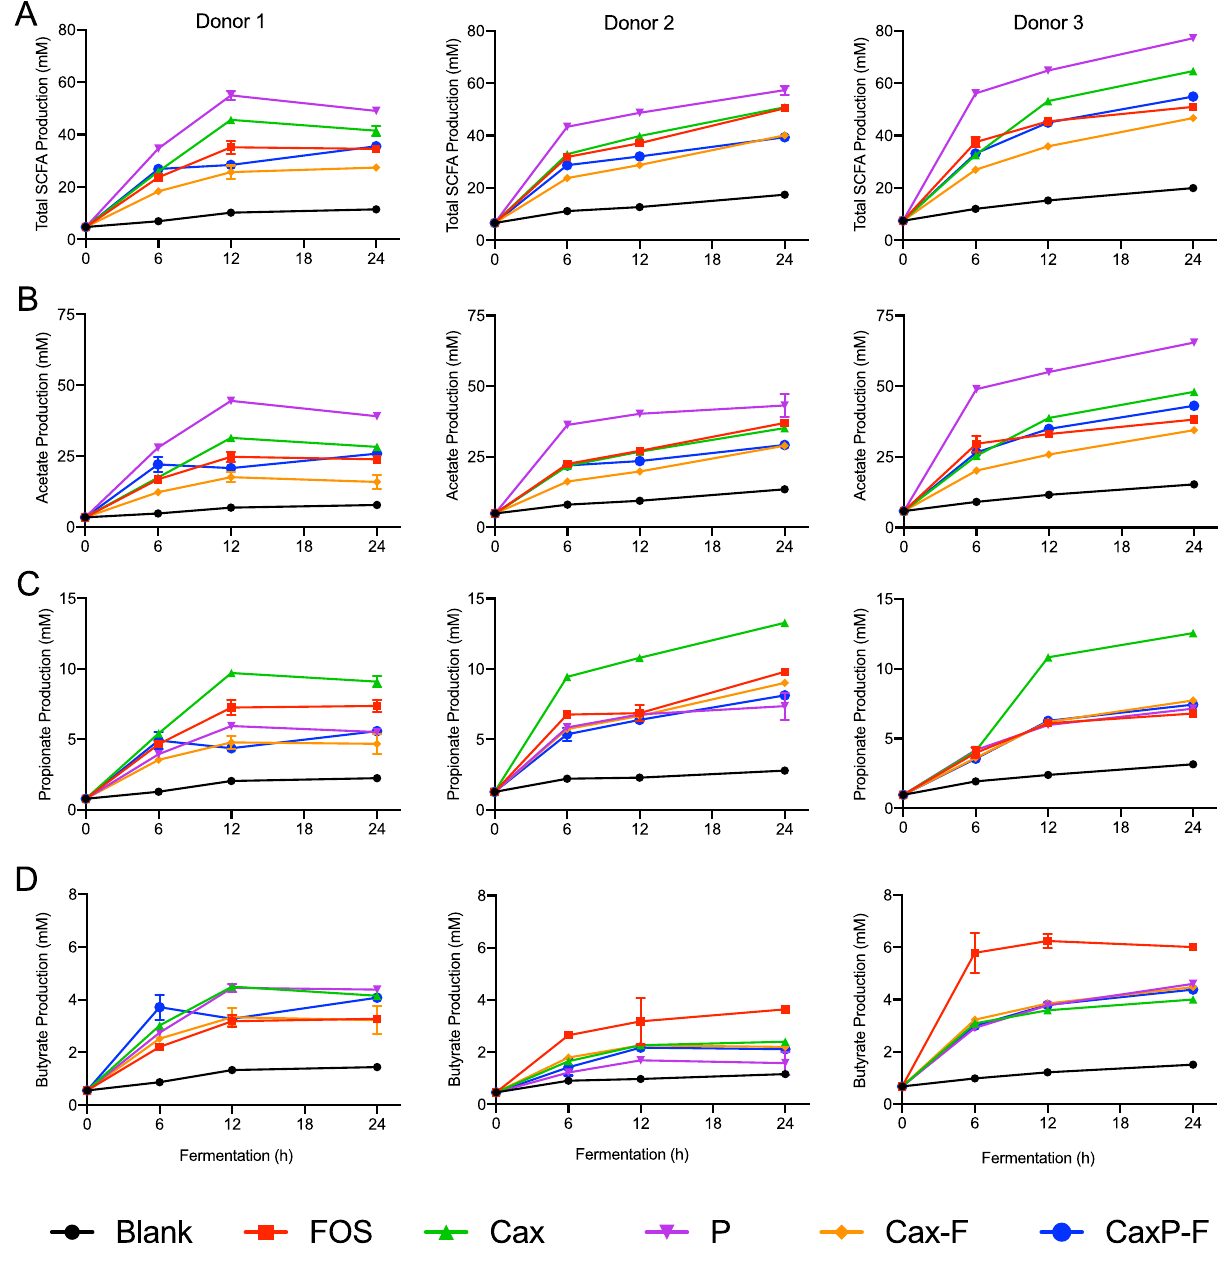
Figure 3. Short chain fatty acid (SCFA) production of 24 h in vitro fecal fermentations of soluble and film fibers in three donors; ( A ) total SCFA, ( B ) acetate, ( C ) propionate, and ( D ) butyrate. Fructooligosaccharide was the positive control. The blank was a negative control with no substrate. Error bars represent the standard error of the mean of three replicates. FOS fructooligosaccharides, Cax arabinoxylan, P pectin, Cax - F arabinoxylan film, CaxP - F arabinoxylan-pectin